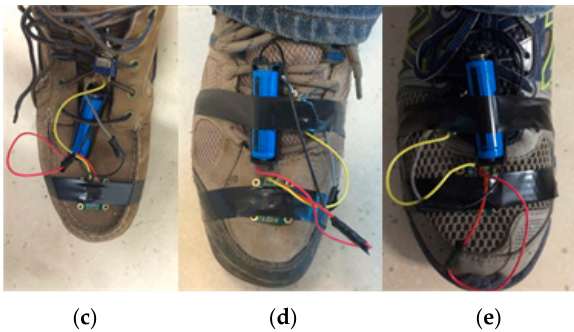
Figure 11. Hardware platform and the sensor placement on shoe. ( a ) Hardware platform of proposed system; ( b – e ) Sensor placement on different testers’ shoes. Table 1. Stepping motion training set.